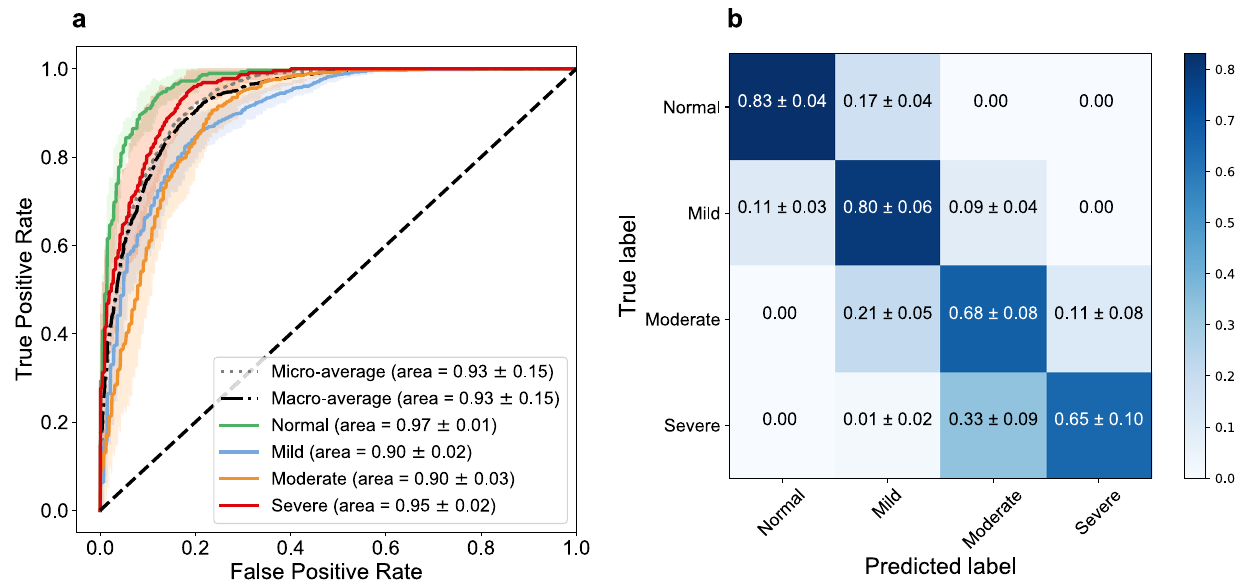
Figure 2. Model performance. ( a ) The receiver operating characteristic (ROC) curves for normal, mild, moderate, and severe classes and the micro- and macro-average ROCs. The solid lines show the means of ROCs over 10 independent test sets, sampled using the bootstrap method. The standard deviations for the ROCs are represented as shadows with a similar color for each class. ( b ) Confusion matrix of the model for the test datasets. The values are shown as the average performance of the model over 10 independent test sets (same as a ) with the corresponding standard deviations. The error in non-adjacent classes (e.g., normal vs. moderate) is zero for all classes (except for severe vs. mild, which has a low error of